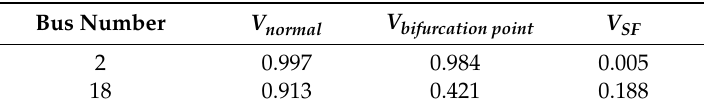
Table 2. Voltage sensitivity factor comparison.